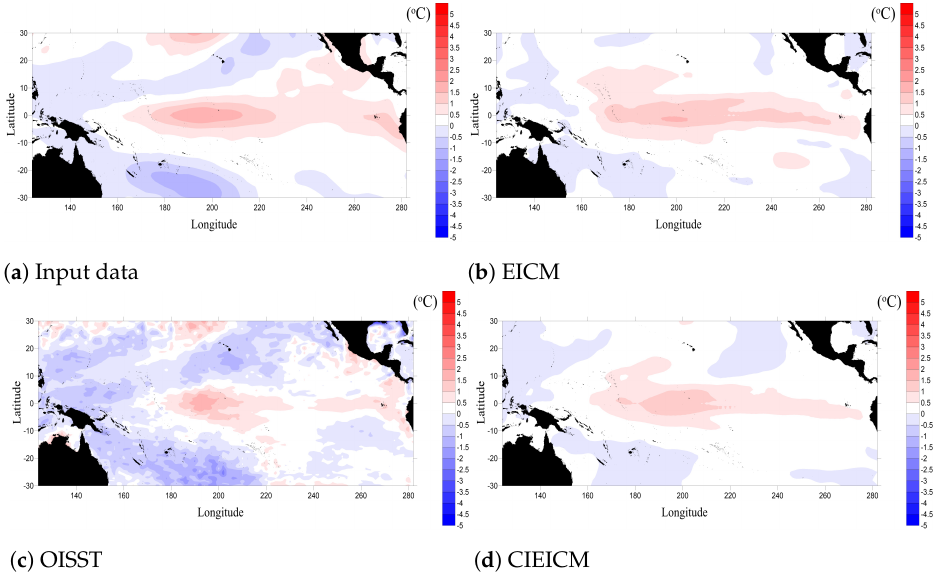
Figure 4. Comparison of the sample results from the EICM and